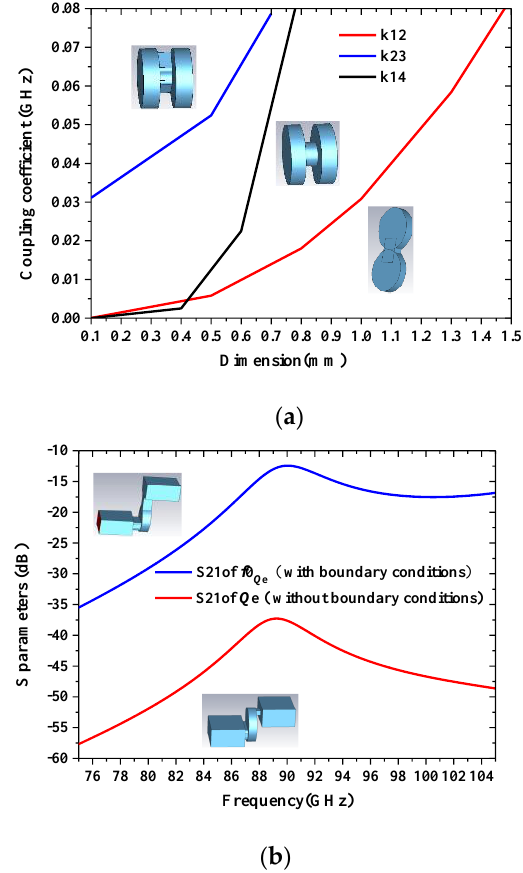
Figure 2. Model and coupling analysis of the cylindrical resonators: ( a ) the relation of inner-mode coupling k versus the coupling irises’ dimensions ; ( b ) extract Qe ’ s S 21 curve and model.